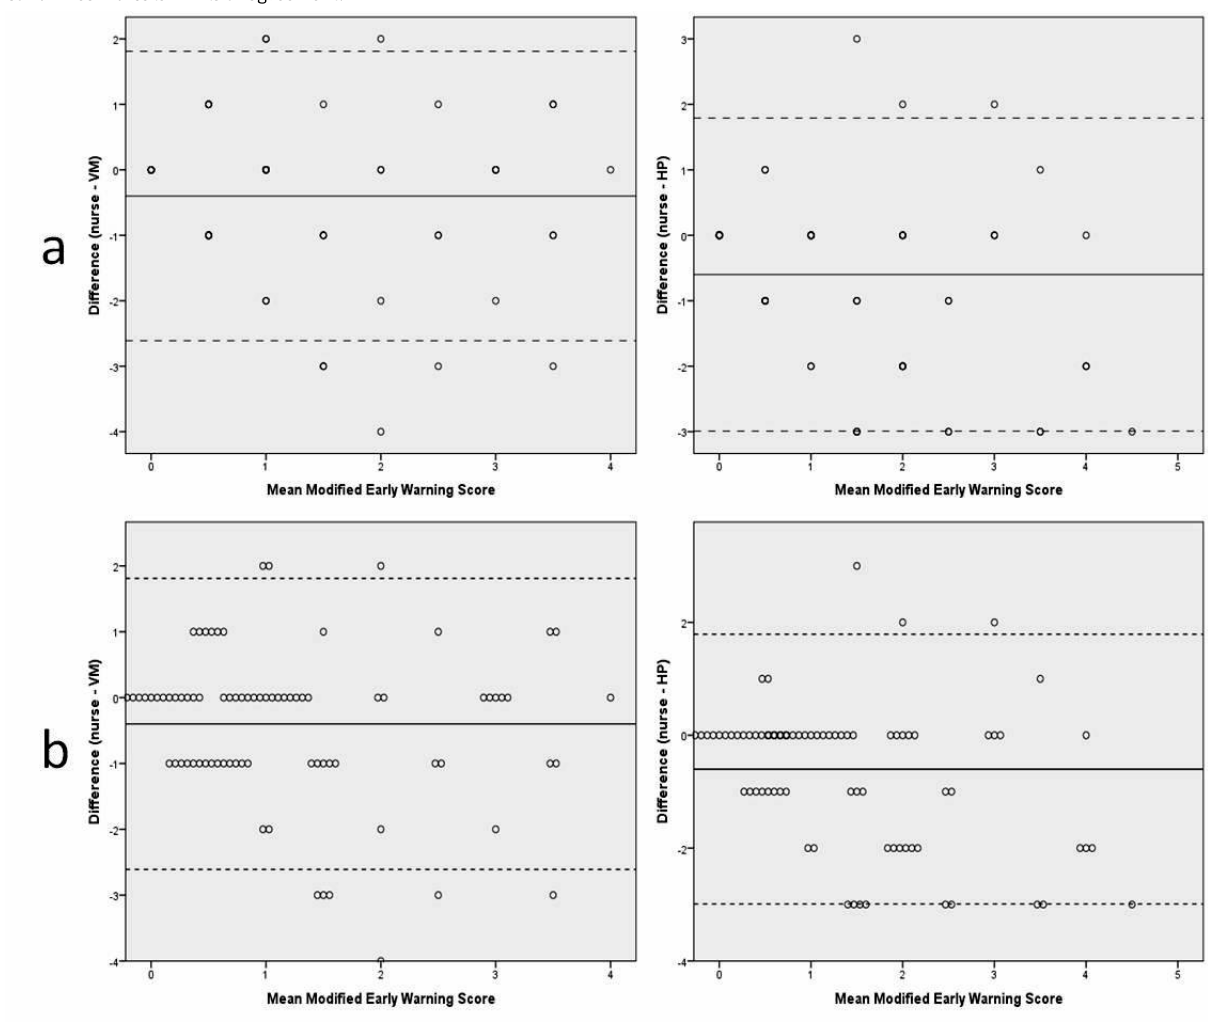
Figure 4. Bland-Altman plots showing modified early warning score: (a) VM and HP, (b) VM and HP (jittered). Dotted lines indicate mean difference and solid lines indicate limits of